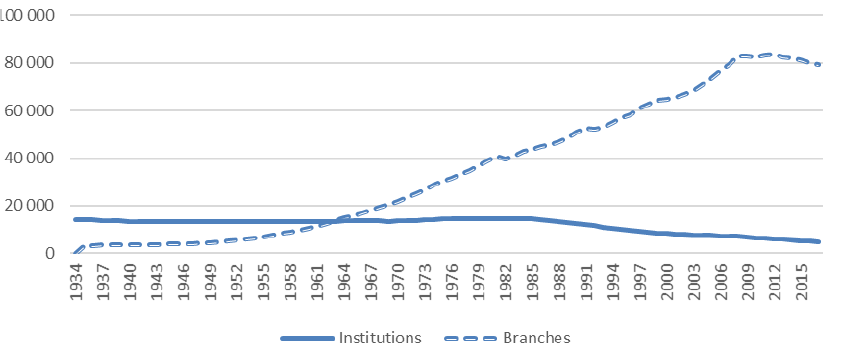
Fig.1 – Number of commercial banks and branches in the U.S. (1934-2017). Source: Federal Deposit Insurance Company